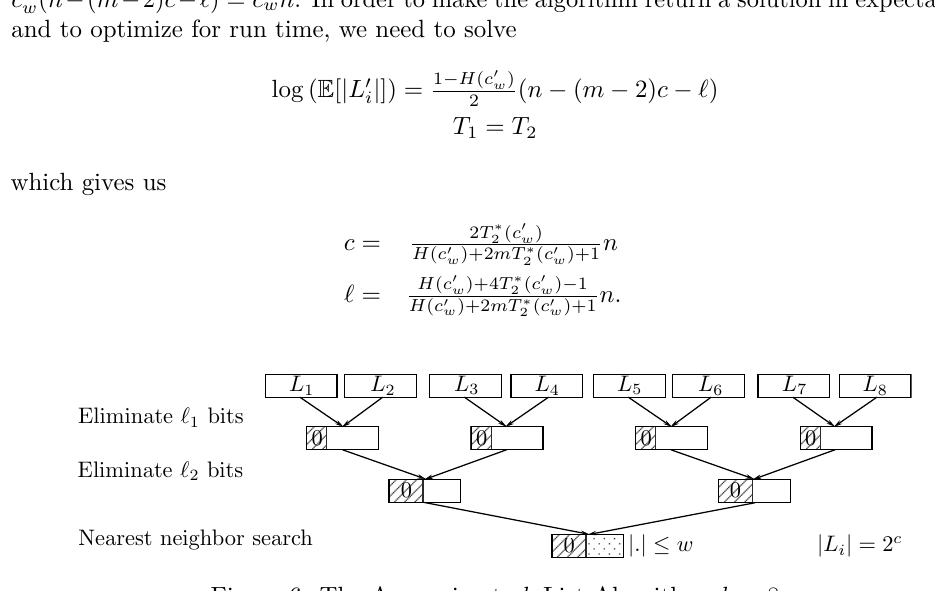
Figure 6: The Approximate k -List Algorithm, k = 8